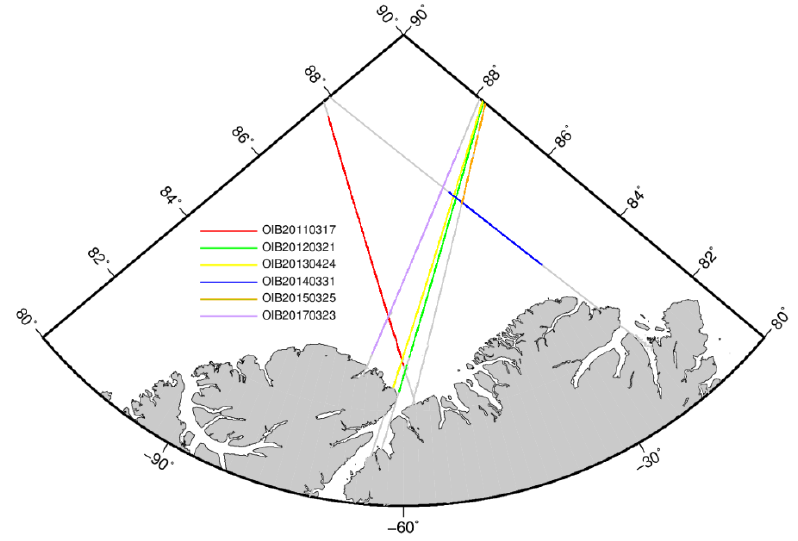
Figure 9. Overlapping tracks of Operation IceBridge (OIB) (colored lines) and CryoSat-2 (gray lines). Table 6. OIB operation times, CryoSat-2 passing times, and distances of the overlapping tracks. ID OIB Operation Time